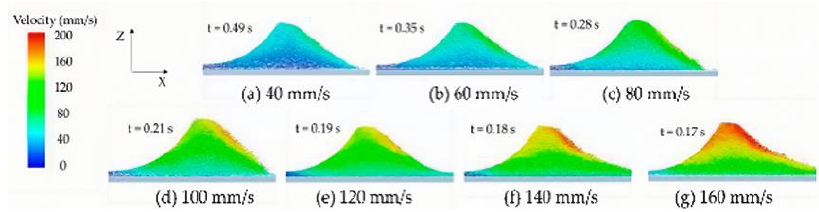
Figure 7. Powder flow velocity under different roller’s translational velocity [ 46].